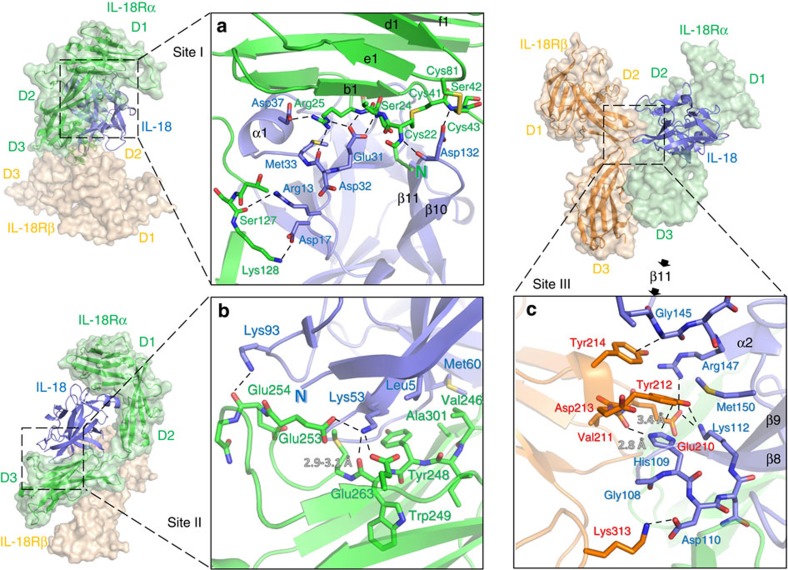
The key residues involved in forming the ternary signalling complex.(a) The interactions in the IL-18 receptor binding Site I. In addition to the area surrounding the stable α-helix I, Asp132IL-18 at the tip of the β10-β11 hairpin exhibits ionic interactions with the structure, which are formed by the two unique disulfide bonds in IL-18Rα. (b) Interactions surrounding the IL-18 Site II. The key residue of Lys53IL-18 is recognized by the IL-18Rα acidic surface through multiple hydrogen bonds. (c) The interface between Site III of IL-18 and IL-18Rβ. In addition to His109IL-18/Tyr212Rβ stacking, multiple hydrogen bonds were observed: the His109IL-18 Nε-H to the Val211Rβ backbone carbonyl oxygen as well as the Lys112IL-18 Nζ-H to the Glu210Rβ side chain and Tyr212Rβ Oη.